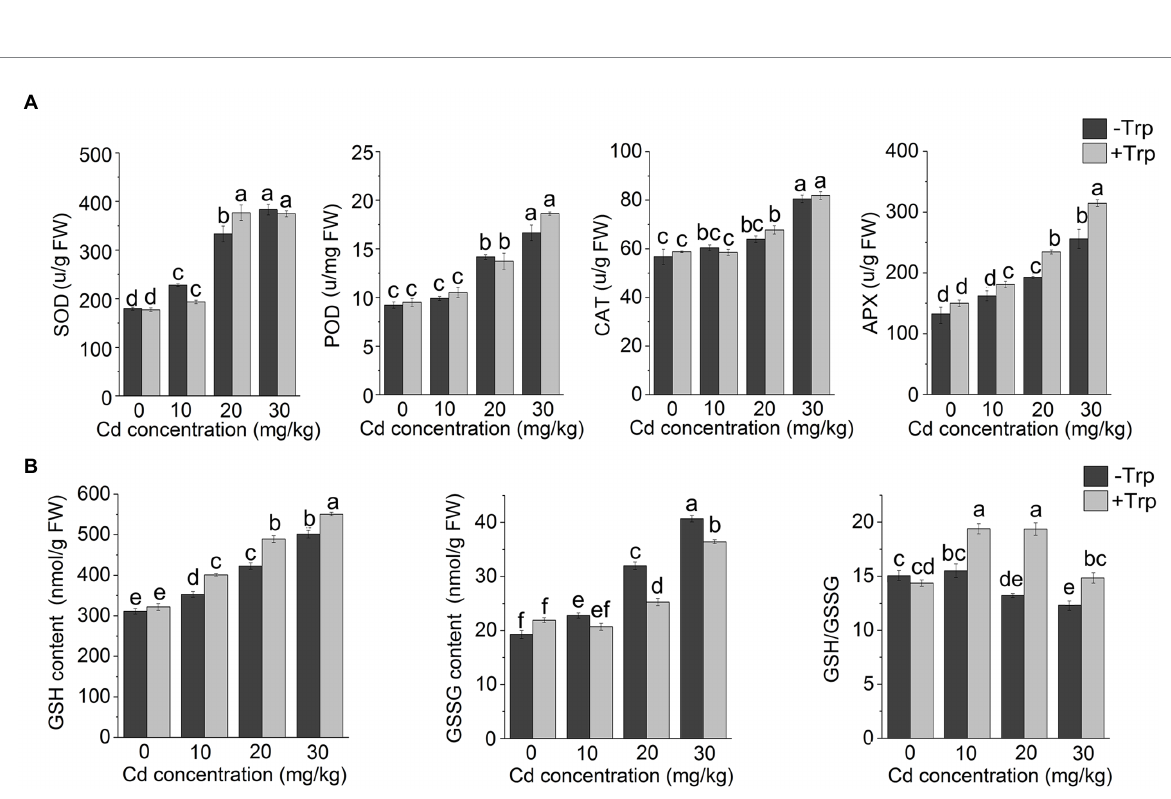
FIGURE 3 Effect of Trp on antioxidant components under Cd stress. (A) Activity of SOD, POD, CAT and APX. (B) GSH, GSSG and GSH/GSSG. Data were averaged from three independent replicates ± SD. Different letters represent significant differences between different treatments ( p ≤ 0.05). FW, fresh